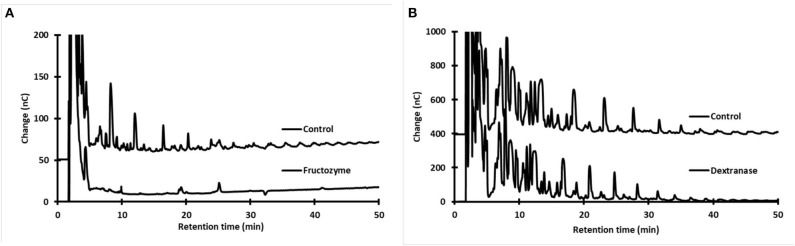
HPAEC-PAD oligosaccharide profile in samples of accumulated aguamiel before and after enzymatic treatment to identify the chemical nature of oligosaccharides. (A) Treatment with Fuctozyme. (B) Treatment with Dextranase. The analyses correspond to samples of accumulated aguamiel from plants P1 and P2 (A. mapisaga).